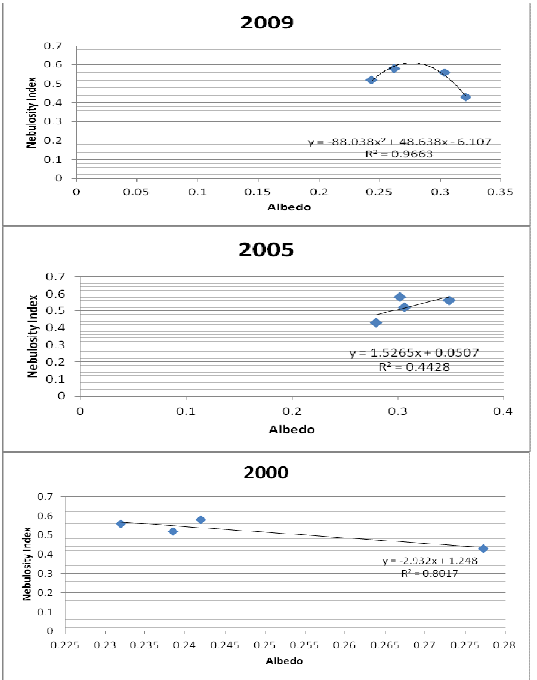
Figure 8. The 5 year Interval Average Trend Analyses While AOD on the other hand, giving negative relationship as the AOD effects the albedo value contradictory. When the AOD is low then the albedo value is high. The linear trend can be seen in Figure 9.